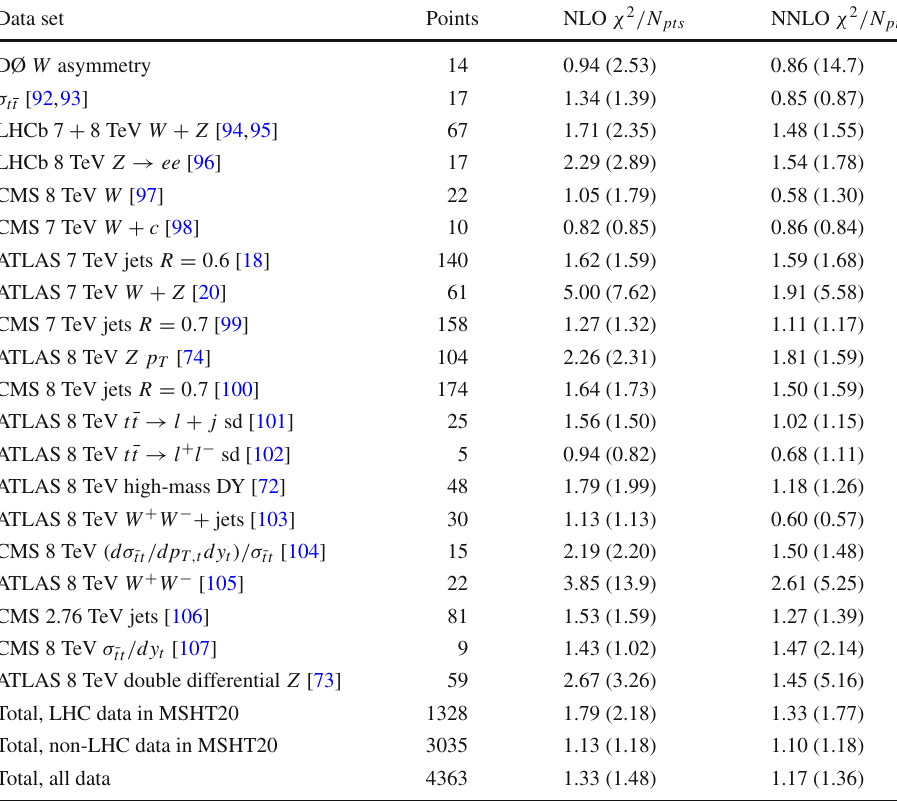
Table 2 χ 2 / N pts at NLO and NNLO for the fit to the new LHC and Tevatron data included in the MSHT20 fit. The corresponding fit qualities are also given for the total LHC and non-LHC data included in MSHT20, as well as the overall fit across all data. In brackets are the predictions obtained using the MMHT14 PDFs (also at α ( M 2 ) = 0 . S Z